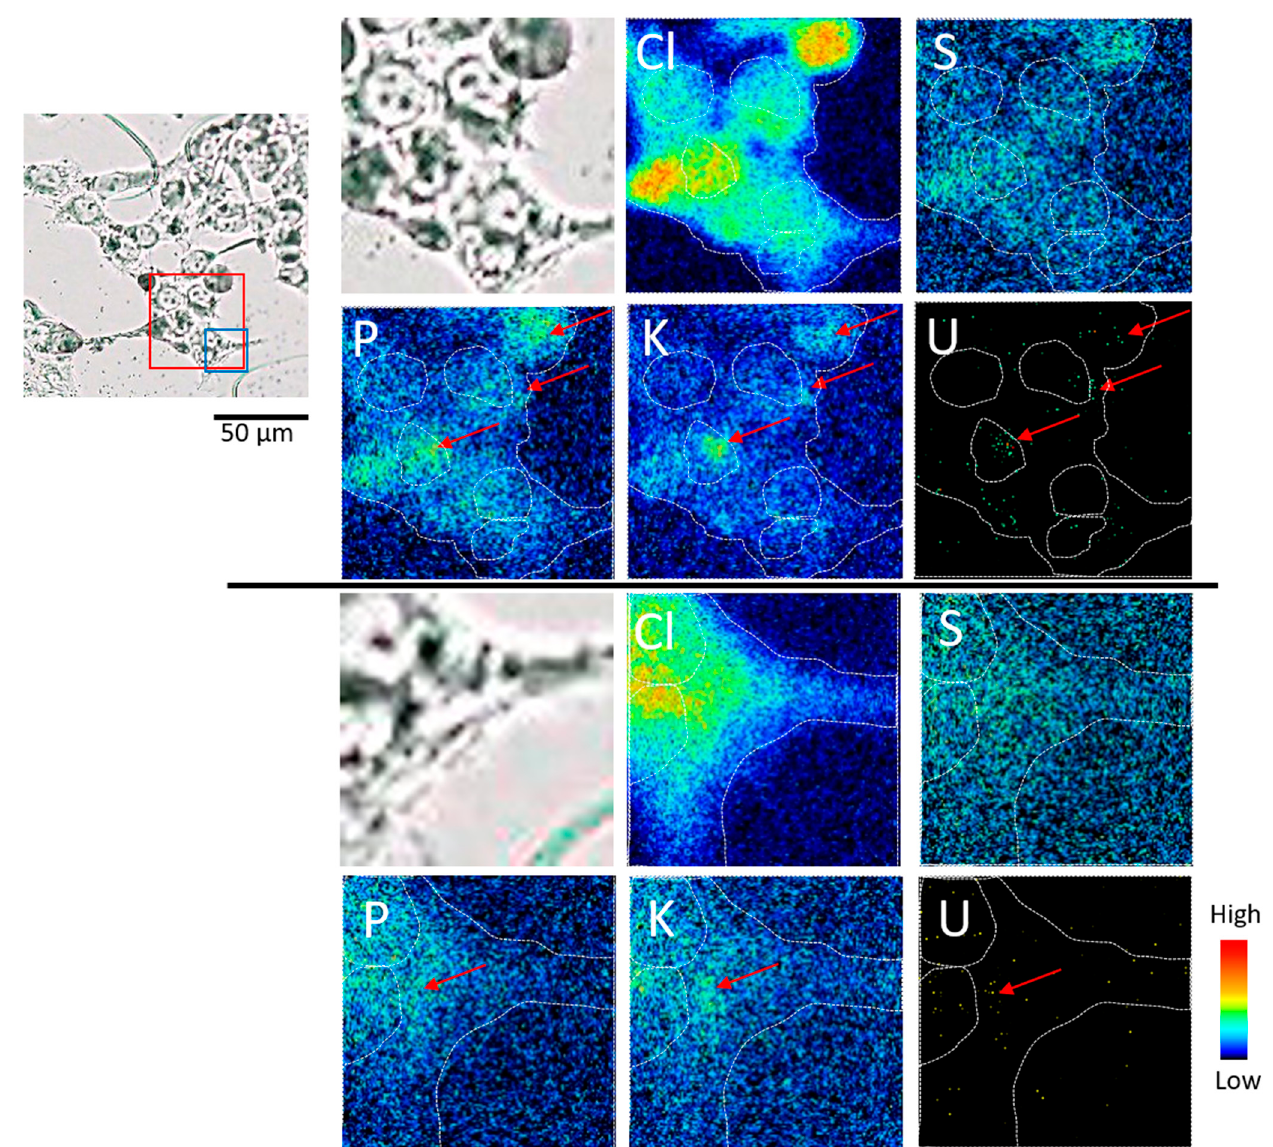
Figure 5. PIXE imaging of uranium-treated S3 cells. ( Left panel ) Photo of S3 cells exposed to uranium for 24 h. Elemental imaging was performed with the following conditions in the boxed areas: scanning area, 50 µ m × 50 µ m (red), 25 µ m × 25 µ m (blue), integrated charge, 0.2 µ C, and beam size, 1 µ m × 1 µ m ( Upper panel ). Elemental images are in the red boxed area ( Lower panel ). Elemental images are in the blue boxed area. Arrows indicate colocalization of phosphorus, potassium, and uranium.